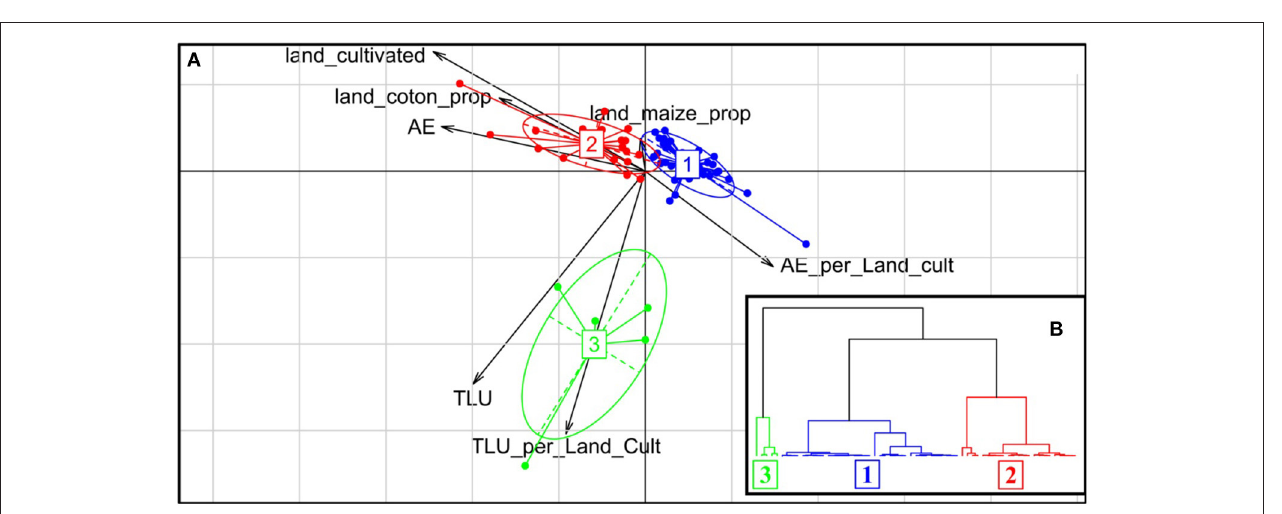
FIGURE 3 | Graphical exploration of the Principal Component Analysis (PCA) and Hierarchical Clustering (HC) for 63 farms: (A) Projection of variables (arrows) and of farmers (colored points) according to their types on the PC1–PC2 plane, (B) Cluster